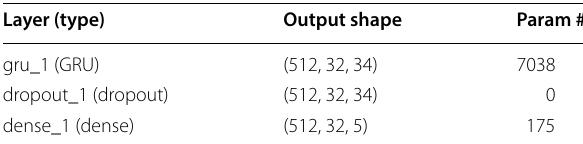
Table 4 Detailed layer information for the proposed GRU